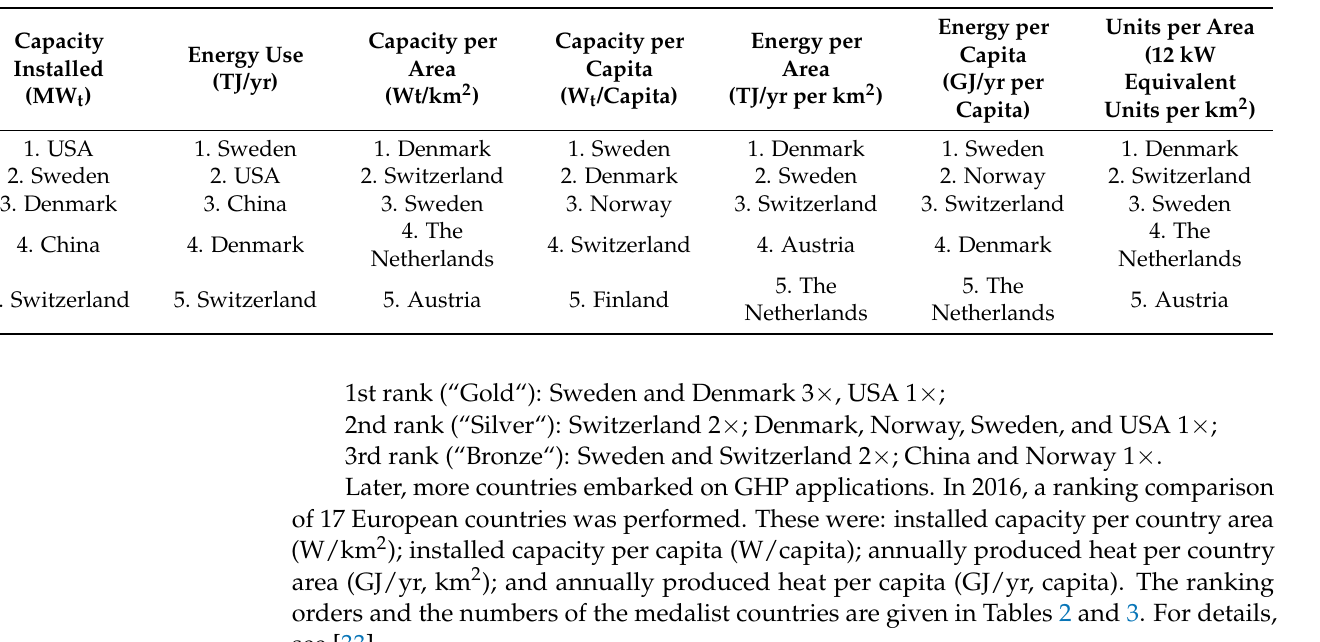
Table 1. Worldwide ranking results of geothermal heat pump utilization in 2004, from